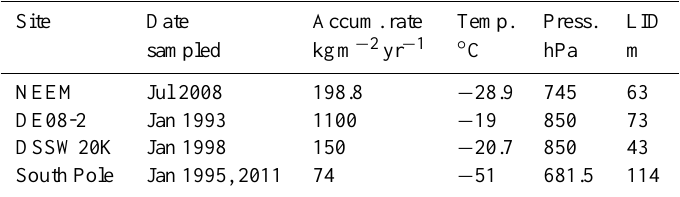
Table 1. Site characteristics.